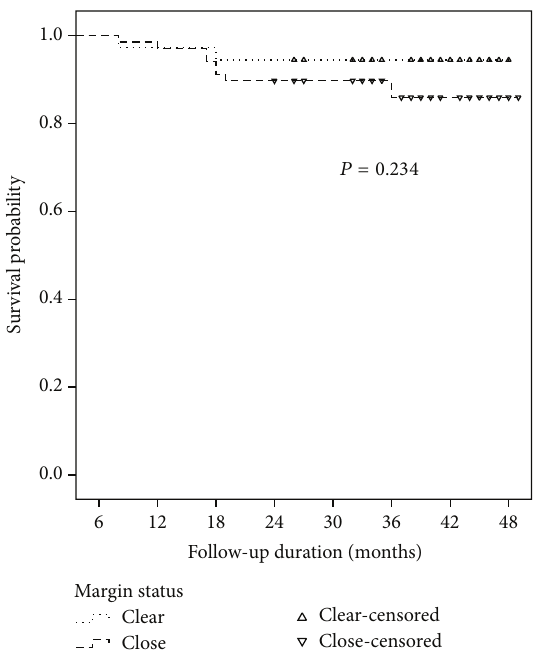
Figure 1: The Kaplan-Meier graph indicating